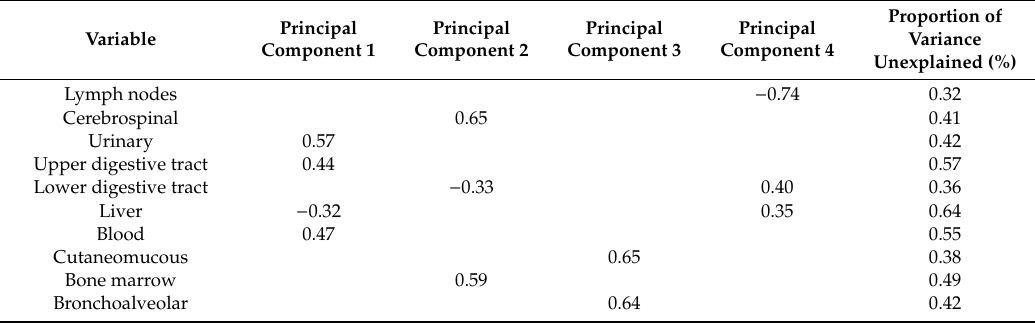
Table 3. Factor loadings with correlations > [0.3] for the four main principal components for sampling sites to identify the infecting